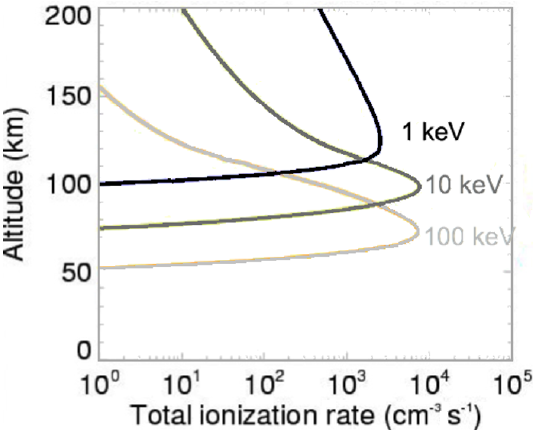
Figure 3. Total ionization rates vs. altitude at various energies of precipitating electrons, as